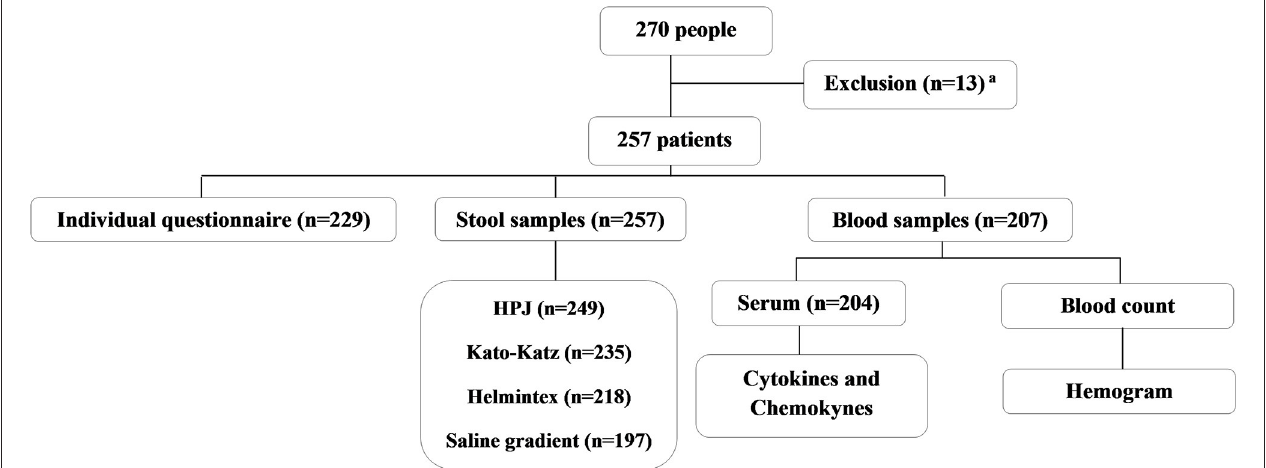
FIGURE 2 | Flowchart describing the endemic population enrolled in the study, the sample collection, and the analyses performed. All the individuals that participated in the study were residents from the rural community of Brejo do Amparo, Januária, Minas Gerais, Brazil. a Residents who did not sign the consent form, did not have the established minimum age allowed for our study, pregnant women and/or individuals with cognitive diseases that would interfere with the obtention of information necessary for the